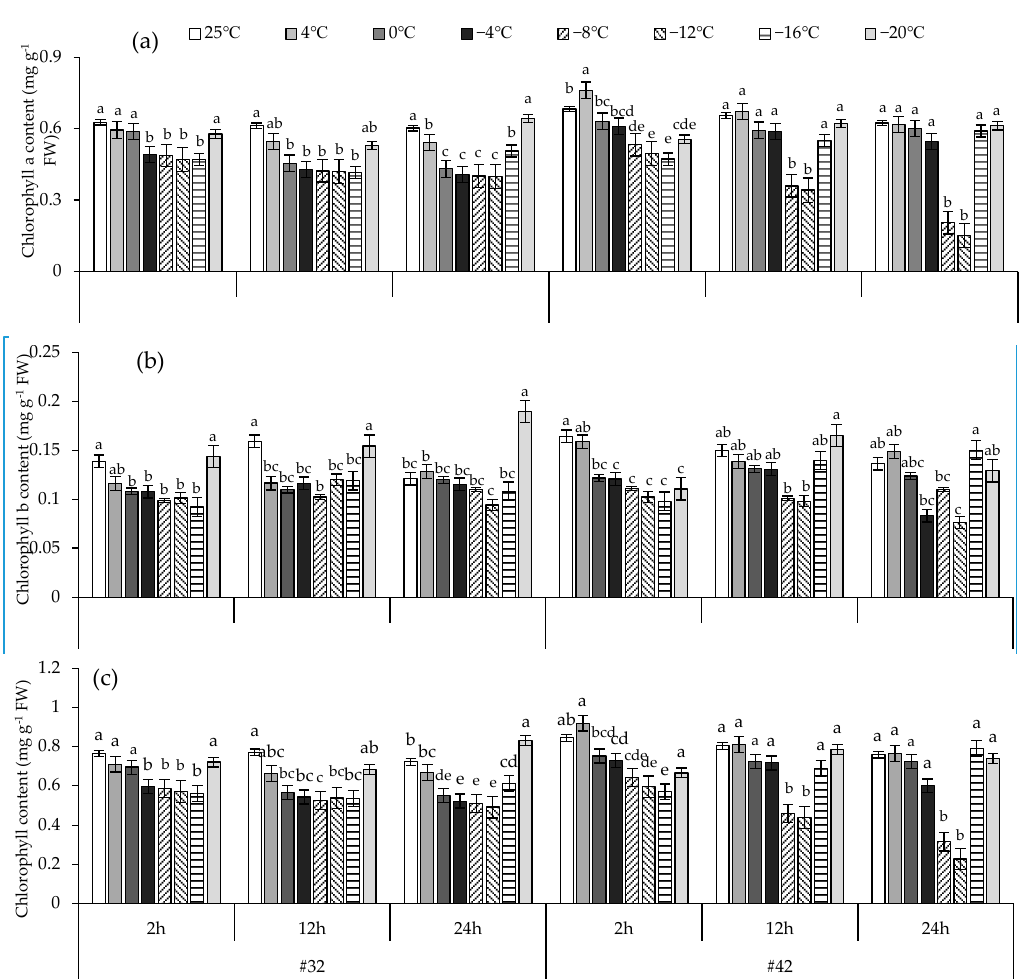
Figure 3. Chlorophyll changes of C. fortunei clones under different low ‐ temperature stress. ( a ) Chlorophyll a content; ( b ) chlorophyll b content; ( c ) chlorophyll a + b content. Each value in the graph is the mean ± standard error ( n = 6). Different patterns indicate different treatment temperatures, and lowercase letters above each bar indicate significant differences ( p < 0.05).